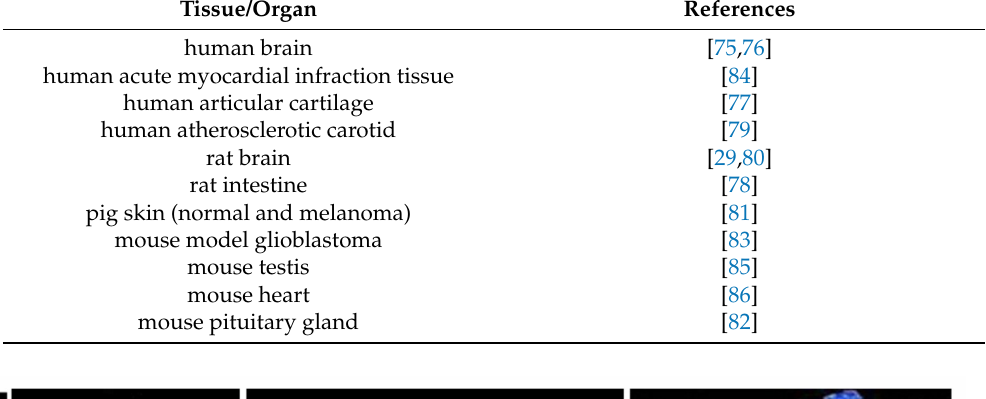
Table 2. In-tissue proteomic analysis of different normal and diseased tissues by MALDI MSI based on MS/MS technique.